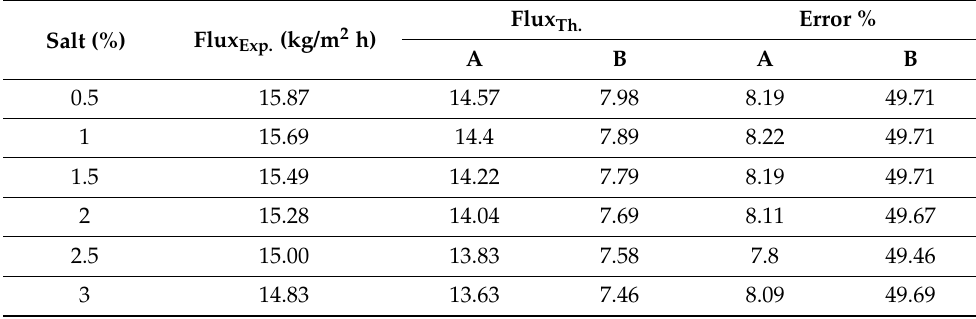
Table A3. The error of experimental and theoretical (with and without spacer) of permeate flux for different salt